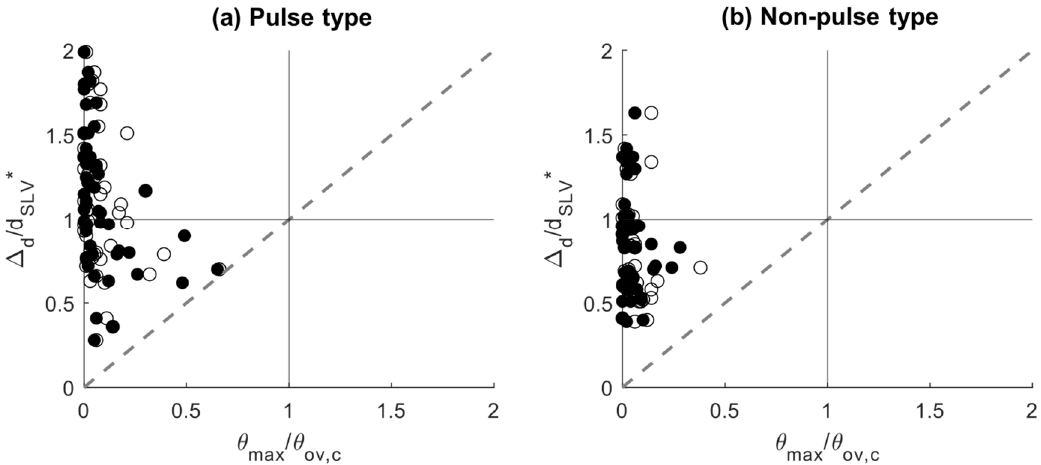
Figure 16. Masonry wall with openings. Comparison of the code-based (equivalent static) and rocking (non-linear dynamic) demand-capacity ratios for both ( a ) pulse and ( b ) non-pulse type recorded ground motions, scaled to a g = 0.35 g.